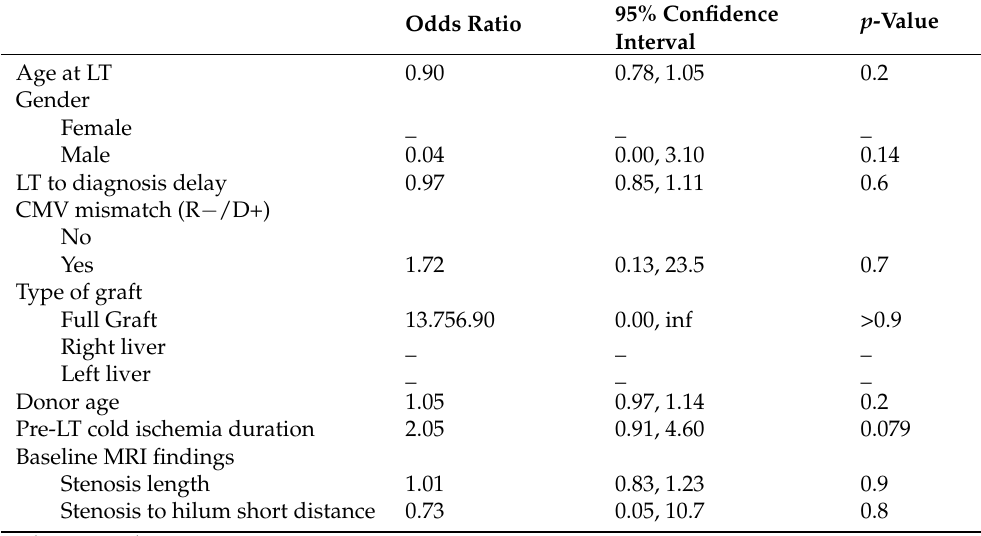
Table 4. Univariate analysis of risk factors associated with recurrence of